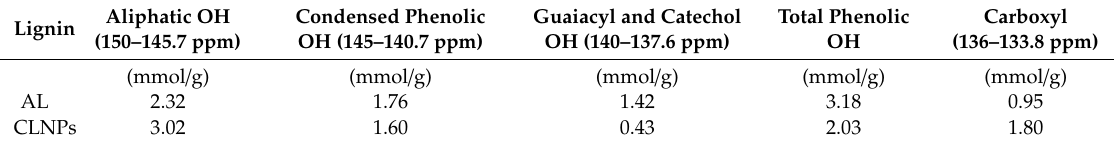
Figure 2. Quantitative 31 P-NMR spectra of the alkali lignin (AL) and CLNPs. Table 1. The contents of functional groups in AL and